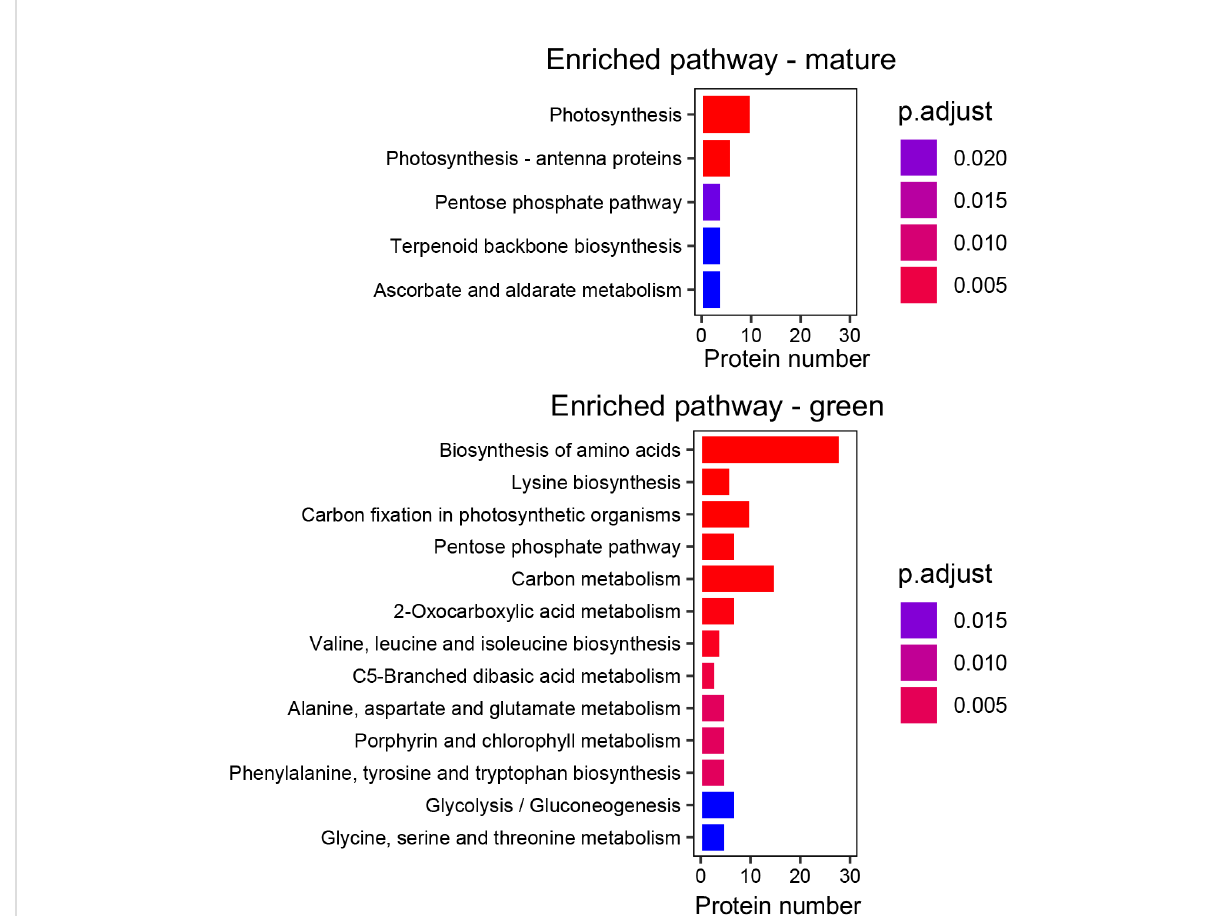
FIGURE 4 Kyoto Encyclopedia of Genes and Genomes (KEGG) pathway enrichment of differentially accumulated proteins (DAPs) in the chloroplasts of Vitis vinifera cv. Vinhão exocarp at the mature stage (E-L 38) vs. the green stage (E-L